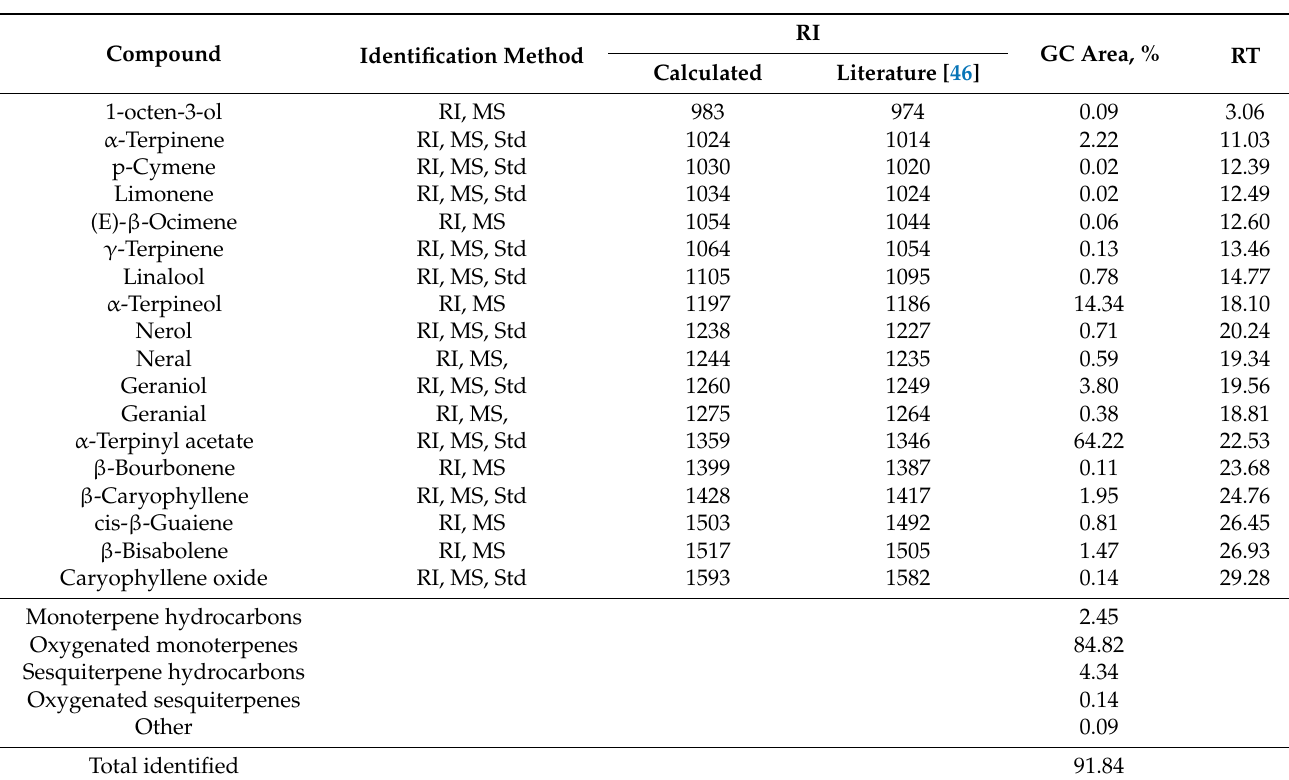
Table 3. Composition of essential oil of Thymus pulegioides α -terpinyl acetate chemotype (GC area %, RI—retention index, MS—mass spectrum, Std—analytical standard, RT—retention time). Mass spectral similarities of investigated compounds were 85–96% (in comparison with computer mass spectra library (NBS75K) and/or analytical